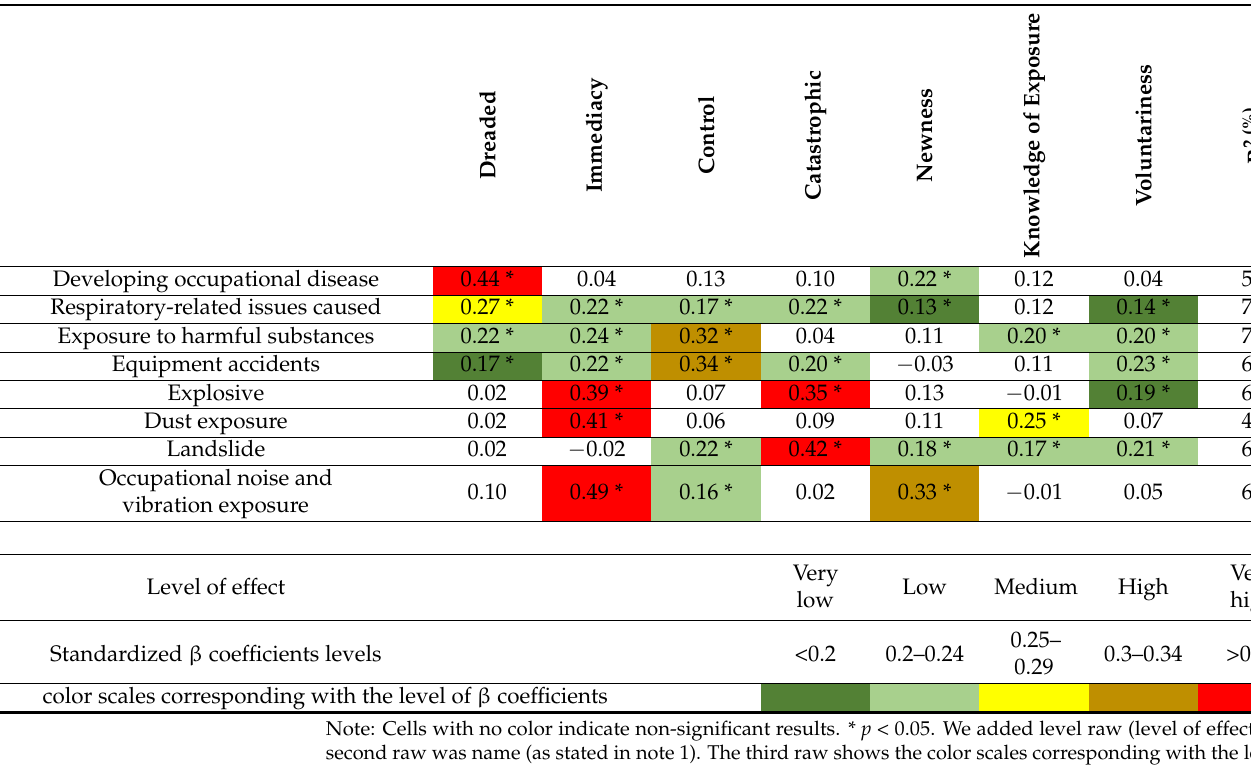
Table 4. Heat map of significant predictors or overall risk ratings for each